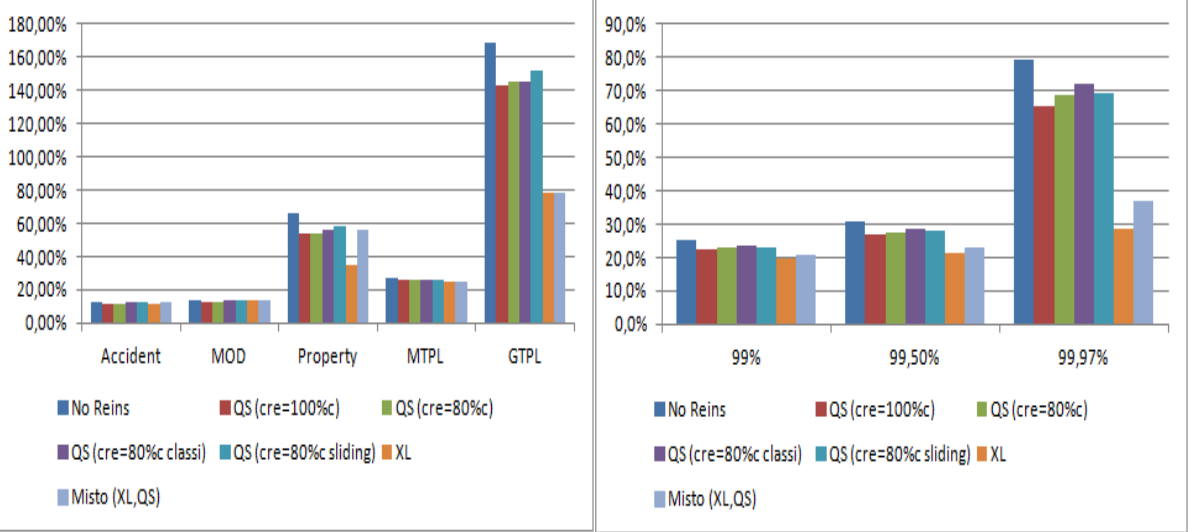
Figure 4. SCR ratio for each LoB and Total SCR ratio according to different reinsurance strategies (E PSILON